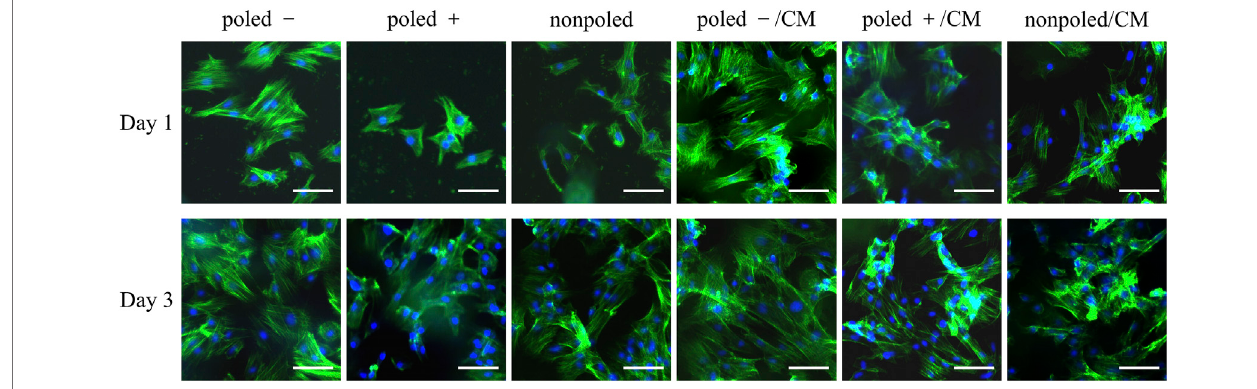
FIGURE 7 | Representative fl uorescence microscopy images of rBMSCs cultured in normal media or conditioned media for 1 and 3 days. Blue fl uorescence represents the nucleus stained with DAPI, and the green fl uorescence indicates the cytoskeleton, stained with phalloidin (scare bars: 50 μ m).